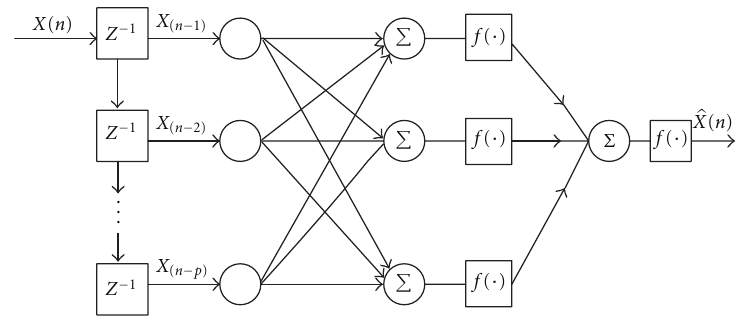
Figure 3: A P -th order multi-layer perceptron network.